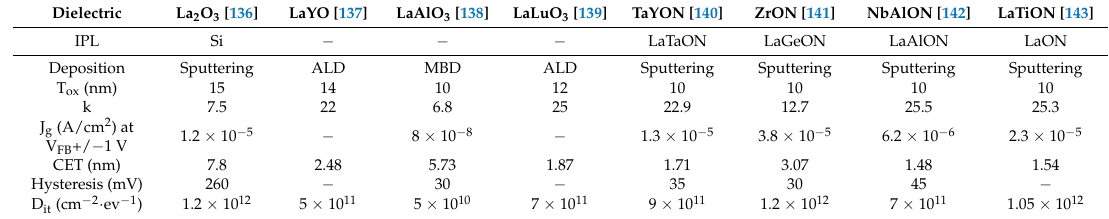
Table 6. Characteristics of GaAs MOS devices with La-based high-k oxides as IPL or gate dielectric. Dielectric La 2 O 3